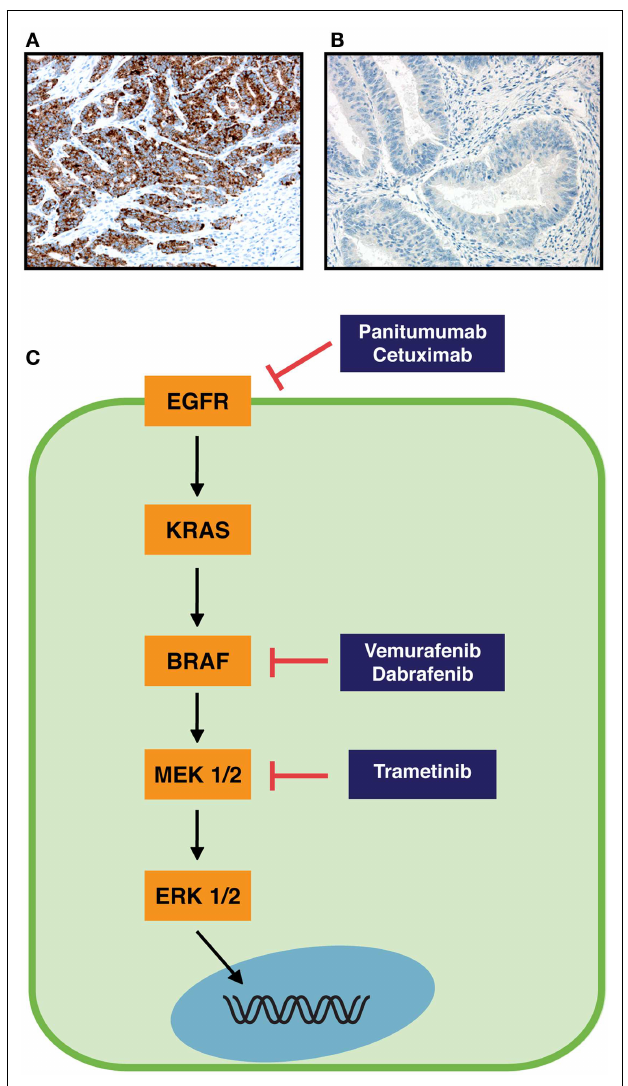
FIGURE 1 | RAS-RAF pathway and immunohistochemical staining of colorectal cancer specimens with BRAFV600E mutation specific monoclonal antibody . (A) Strong immunopositivity in cancer cells with a BRAFV600E mutation. (B) No staining of cancer cells in a specimen without BRAFV600E mutation. Original magnifications are 200 × . (C) Schematic RAS-RAF pathway (orange boxes) and inhibitors of components of this pathway (blue boxes). Arrows indicate an activation process, and blocked arrows an inhibition